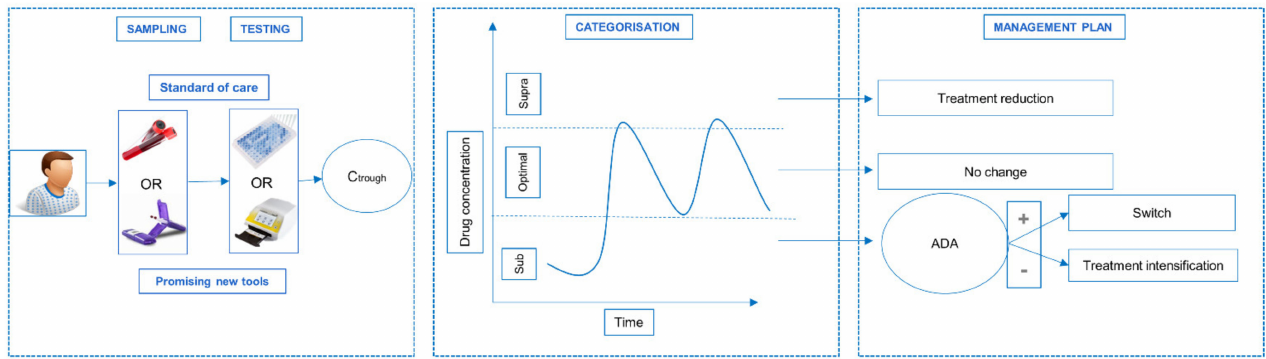
Figure 1. Concept of therapeutic drug monitoring. Therapeutic drug monitoring as proposed in the SUPRA-A trial: blood from the patient is sampled at trough as either whole blood (venipuncture or finger prick). Adalimumab (ADM) concentrations can then be quantified by ELISA or lateral flow testing (LFT). Based on the therapeutic window of ADM (dotted horizontal lines in graph) [8,9], the patients’ trough levels can be categorized into three categories: supratherapeutic (above upper thresh- old of window), optimal (within window), or subtherapeutic (below lower threshold of window). Depending on the categorization, a management plan is set up by the physician and the dose admin- istration can be adapted. In case of subtherapeutic levels, additional testing of immunogenicity may be required to detect anti-drug antibodies (ADA). If ADA-negative, a dose increase (intensification) may be needed. If ADAs are present, a treatment switch is recommended. Figure adapted